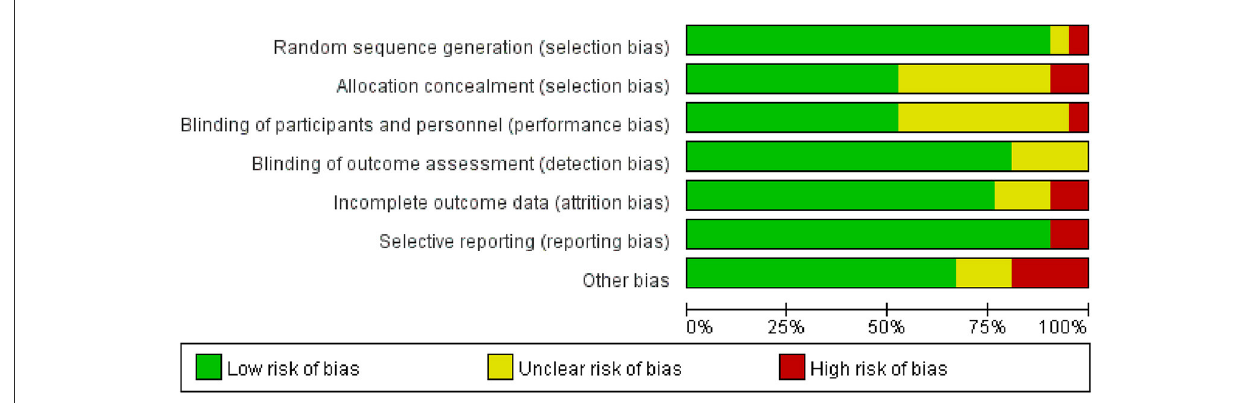
FIGURE2 Risk of bias graph of RCTs.